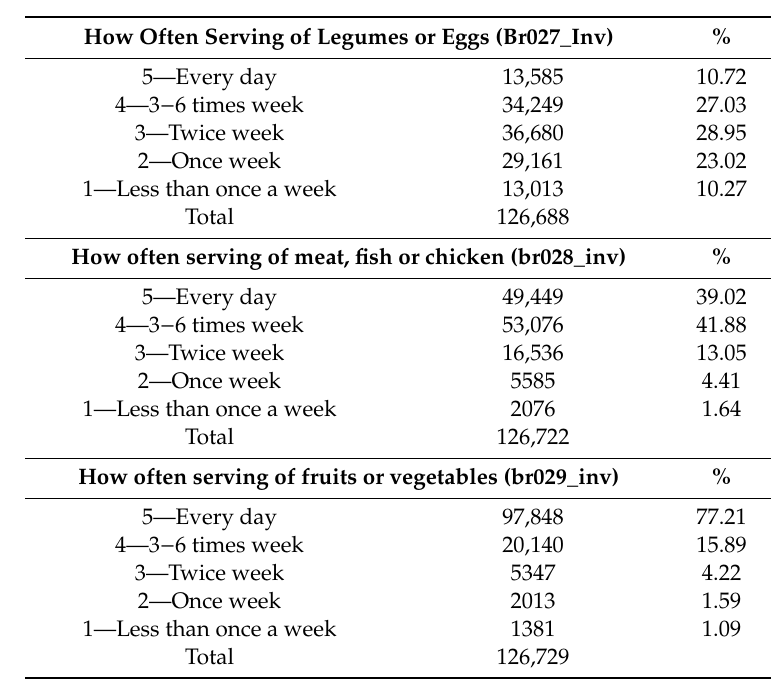
Table A4. Dietary patterns and number of respondents, with percentages.